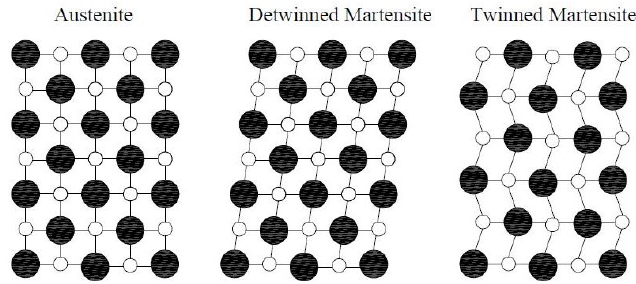
Figure 8. Different crystal structures (phase structures) of SMAs.